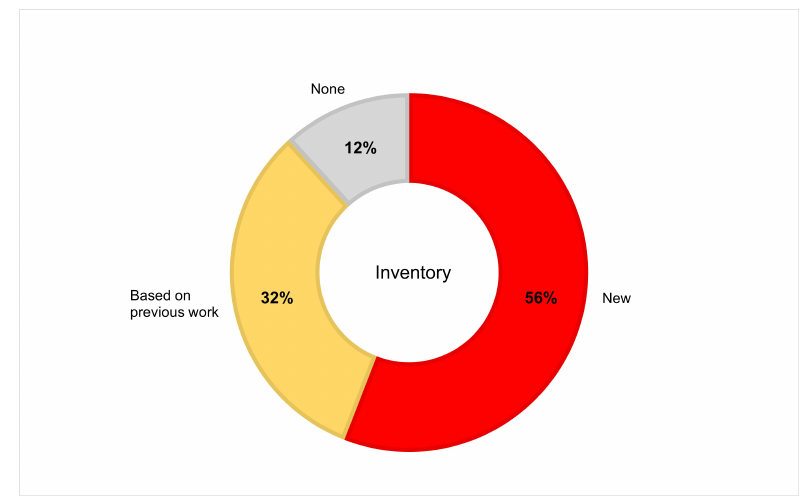
Figure 8. Origin of the landslide inventory used in the reviewed studies. Table 2. Criteria for the recognition and mapping of landslides in